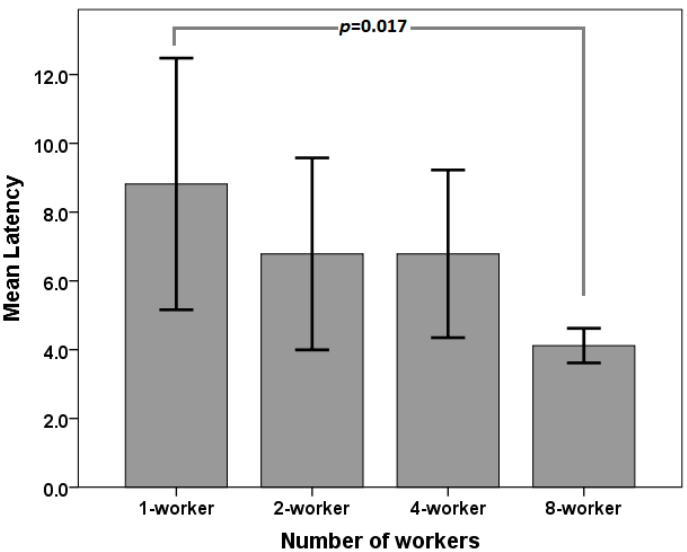
Figure 5. Mean latency: significant difference in the average response time between one-crowd and eight-crowd conditions.